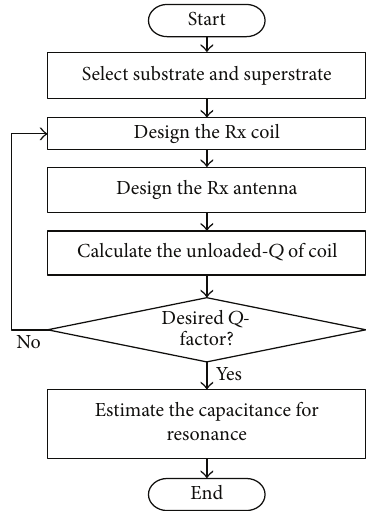
Figure 4: Design process of the integration of the resonant coil and MICS antenna.